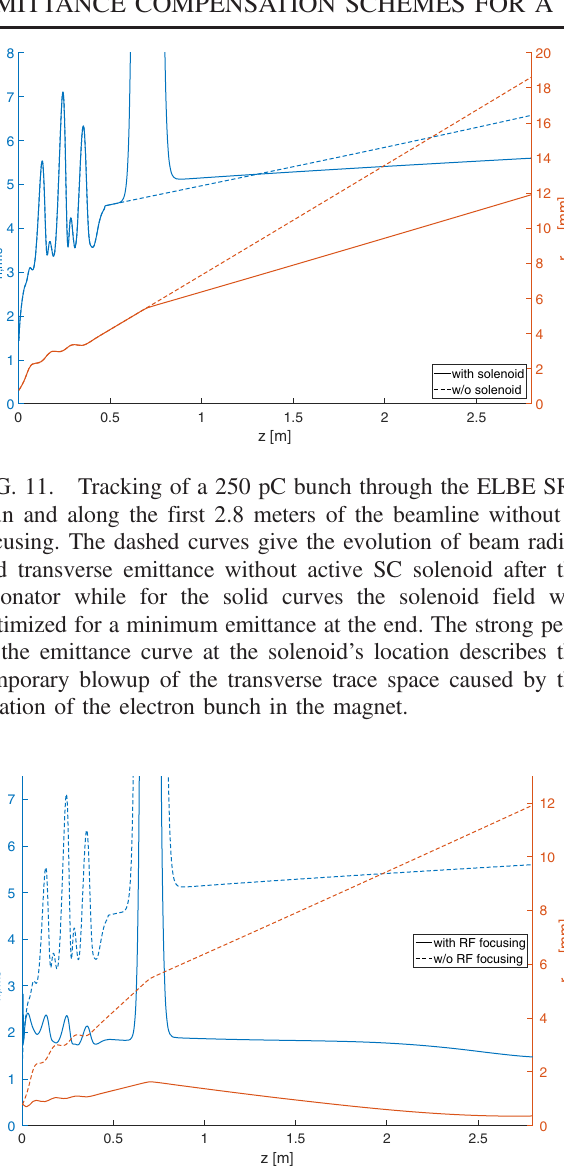
FIG. 12. Tracking of a 250 pC bunch through the ELBE SRF Gun and along the first 2.8 meters of the beamline. The dashed curves give the evolution of beam radius and transverse emittance for an optimized solenoid field without rf focusing, correspond- ing to the solid curves in Fig. 11. The solid lines represent the result of the combination of rf focusing and the SC solenoid at the gun ’ s exit.